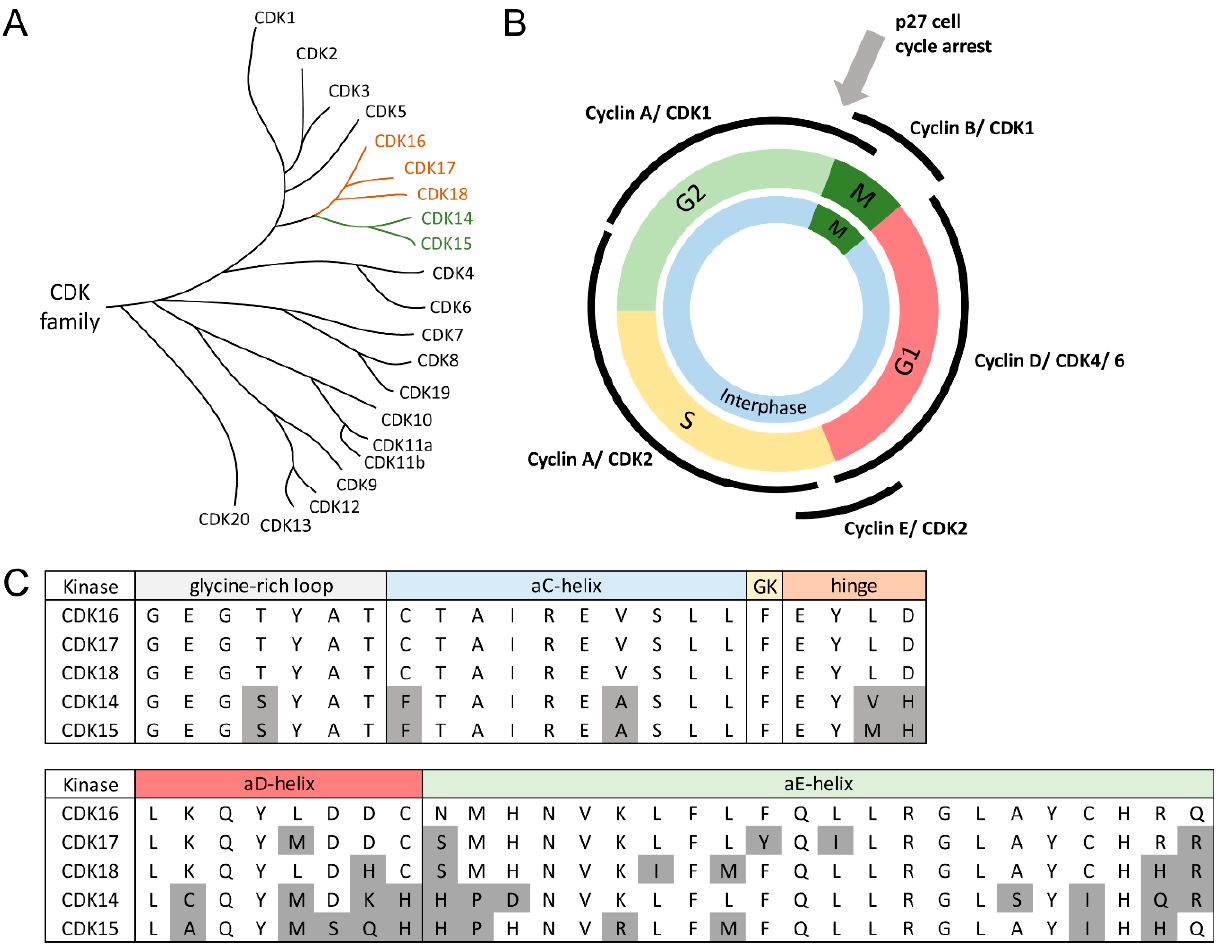
Figure 1. ( A ) Phylogenetic tree of the CDK family. The PFTAIRE subfamily is highlighted in green, the PCTAIRE subfamily in orange (Adapted from Wells et. al.,) [1]. ( B ) Overview of the cell cycle phases and the involvement of CDK’s 1,2,4 and 6 in the transitions through the different phases (Adapted from Suryadinata et.al.,) [10]. Dysregulation of p27 through CDK16 led to a G2/M phase cell cycle arrest. ( C ) Alignment of key residues of the ATP binding pocket of CDK14–18. Differences in comparison to CDK16 are highlighted in grey.